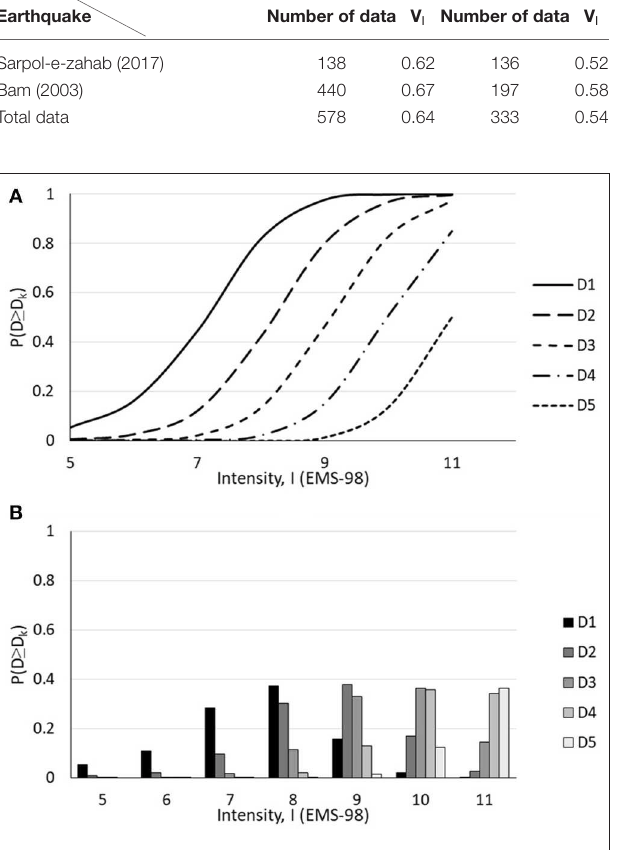
FIGURE 10 | (A) Fragility curves and (B) damage distribution as a function of intensity for Sarpol-e-zahab and Bam URM buildings (original).